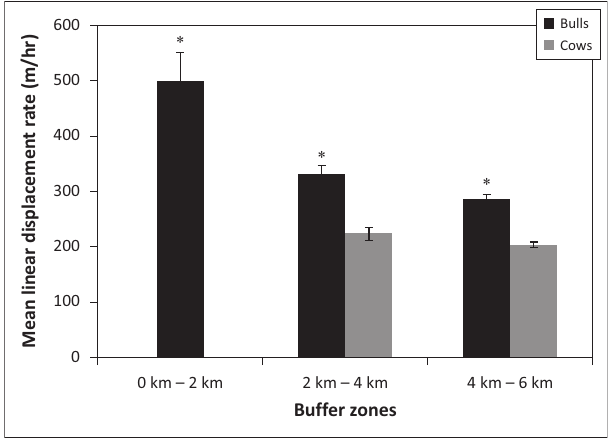
FIGURE 3: Mean linear displacement rate of bulls and cows across buffer zones surrounding studied villages. Error bars indicate standard error. Asterisks indicate significantly different displacement rates ( P <